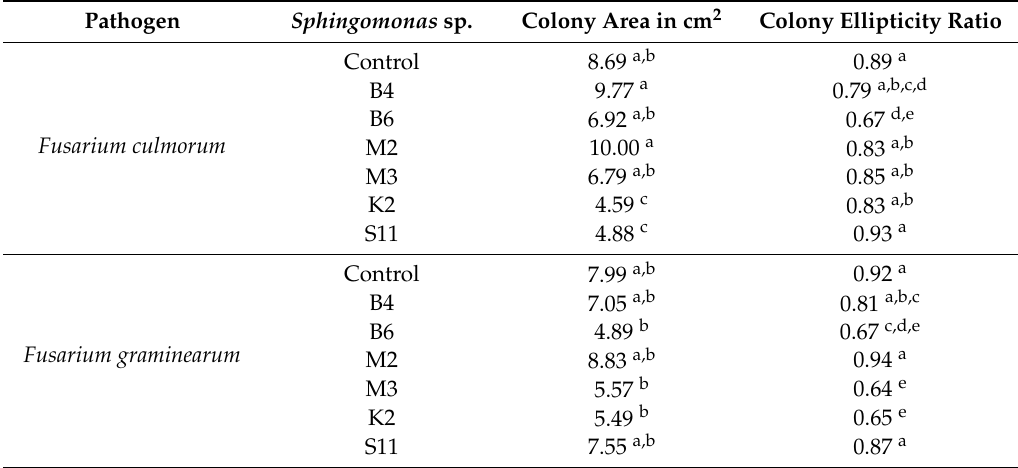
Table 3. Inhibitory e ff ect of bacterial isolates of the genus Sphingomonas on Fusarium pathogens in the dual-culture test.